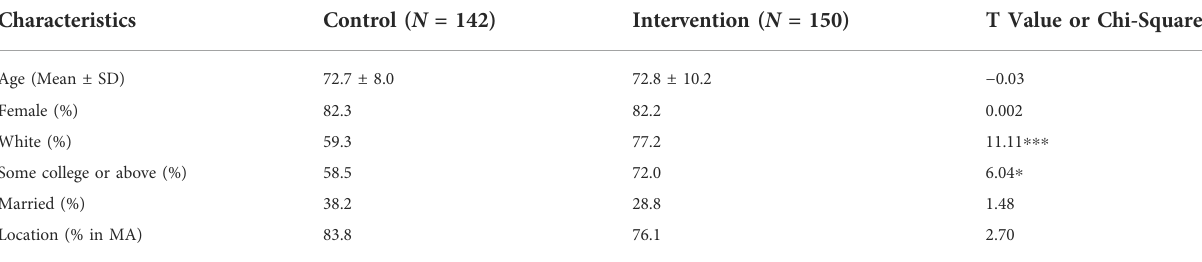
TABLE 3 Characteristics of participants at